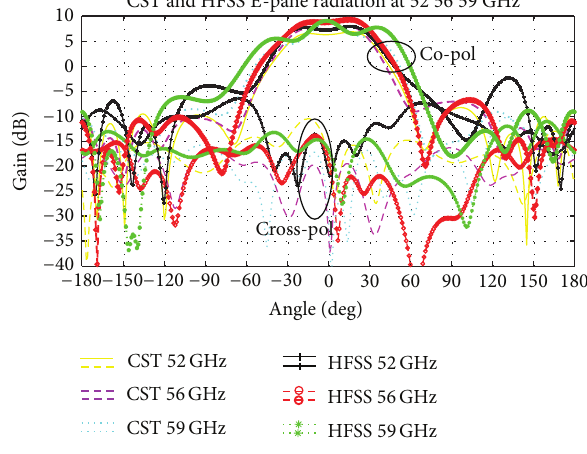
Figure 4: E-plane radiation patterns.